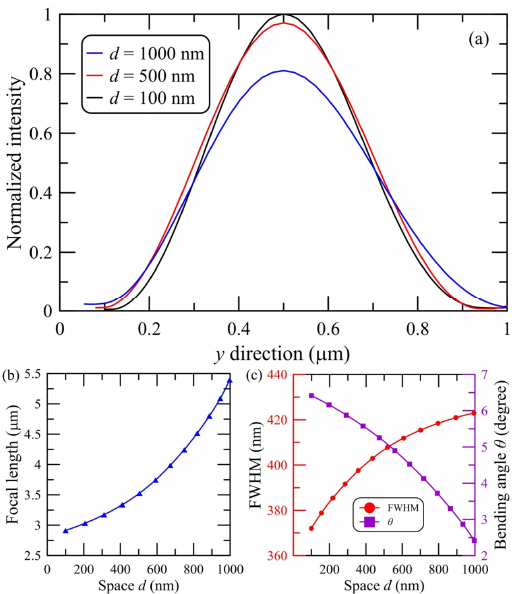
Figure 7. ( a ) Normalized intensity profiles of the photonic hooks along the y direction for triangular Janus micro-prisms at different spaces d . ( b ) Focal length, ( c ) FWHM and bending angle as a function of the space d of the triangular micro-prisms.